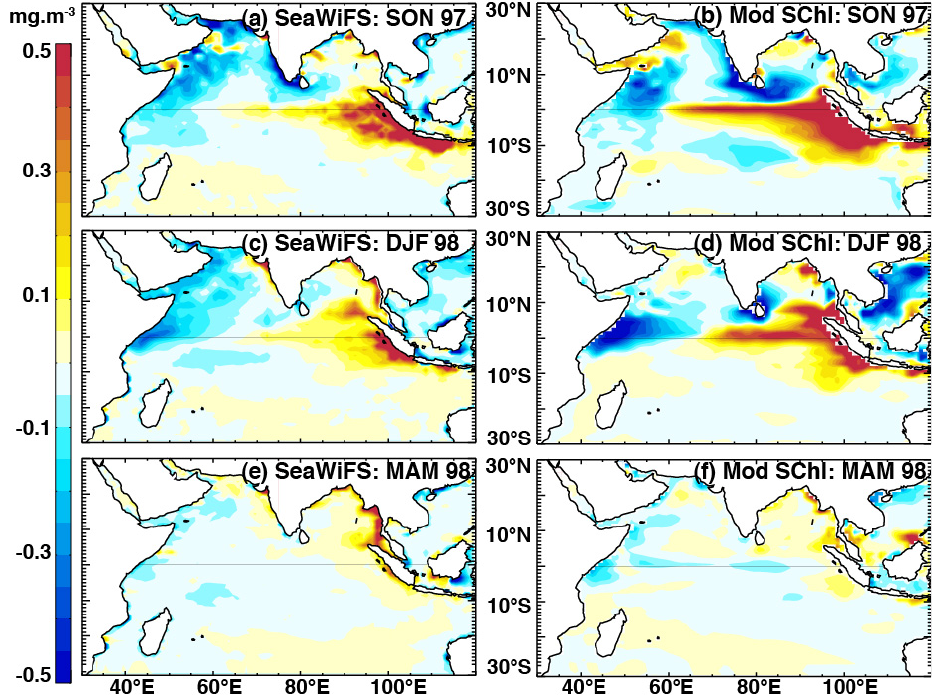
Fig. 2. Anomalies of S Chl during the 1997/1998 event from SeaWiFS satellite estimates (left panels) and model outputs (right panels). Anomalies were calculated with respect to a 1998–2009 climatology for SeaWiFS and a 1990–2001 climatology for the model (see Sect. 3 for details). Season abbreviations as in Fig.